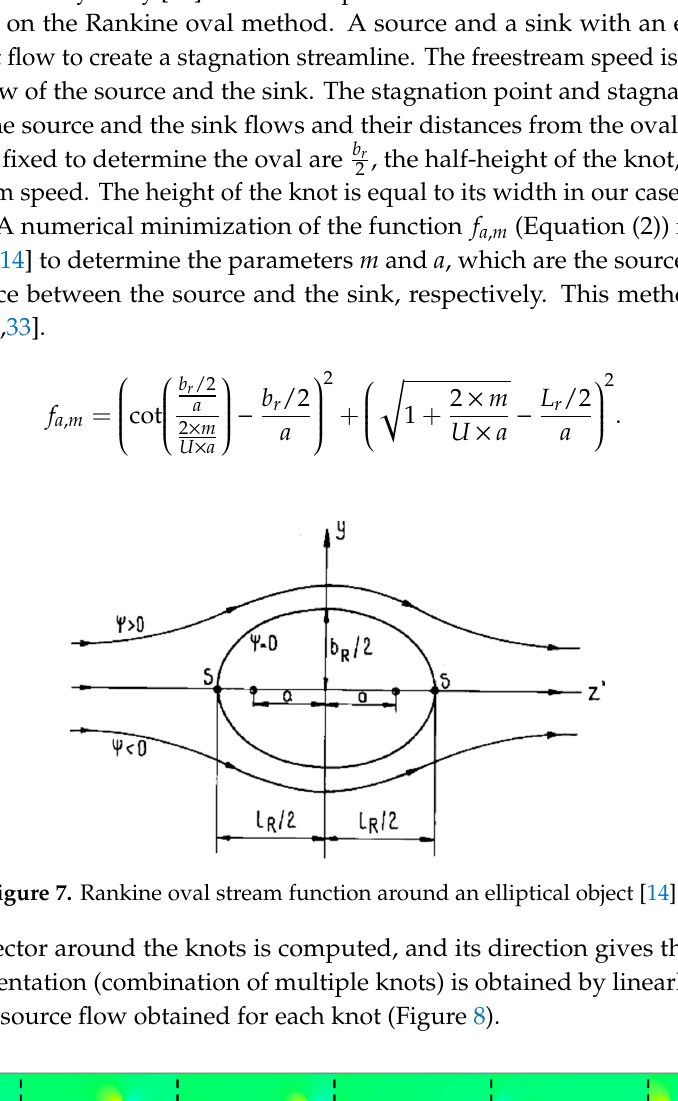
Figure 6. Example of veneer knot map.